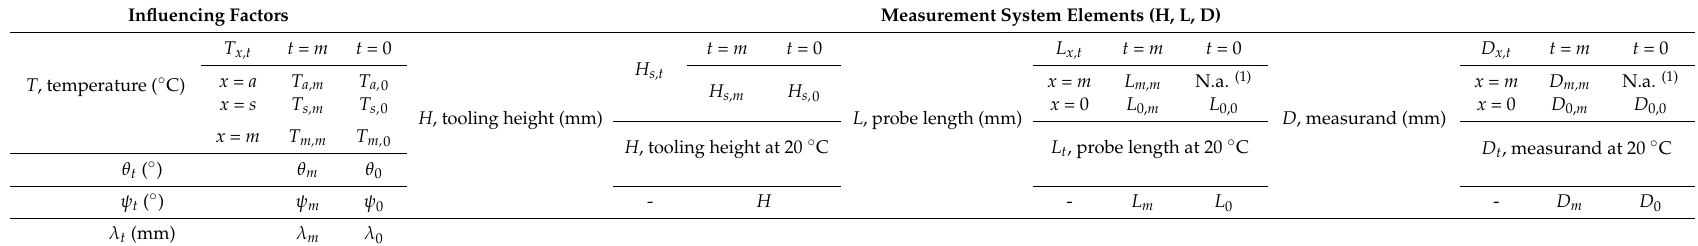
Table 2. Factors influencing the measurement result and system elements.